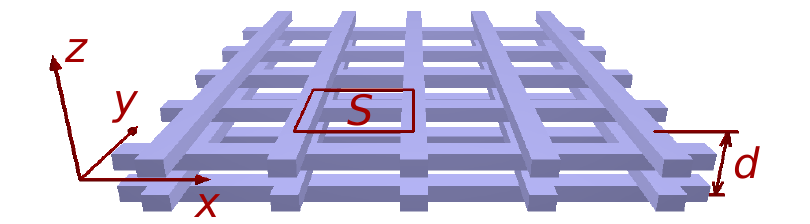
Figure 1. Example of a 2D-periodic holey slab, here composed of two layers of the so-called woodpile structure. This model idealizes structures easily produced by 3D-printing [24]. The unit cell projected onto the horizontal ( x , y ) plane is the surface S . The thickness of the slab is d , here twice the height of the unit